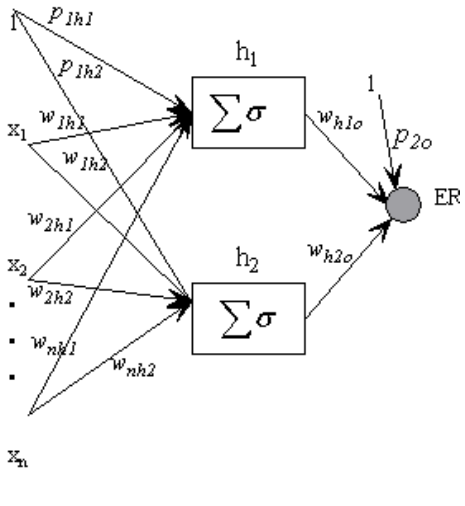
Figure 1. Artificial neural network model using one hidden layer and two nodes. The input vector is connected to the hidden neurons through weights w and p . The hidden layer and output variable are also connected. A nonlinear activation function σ is